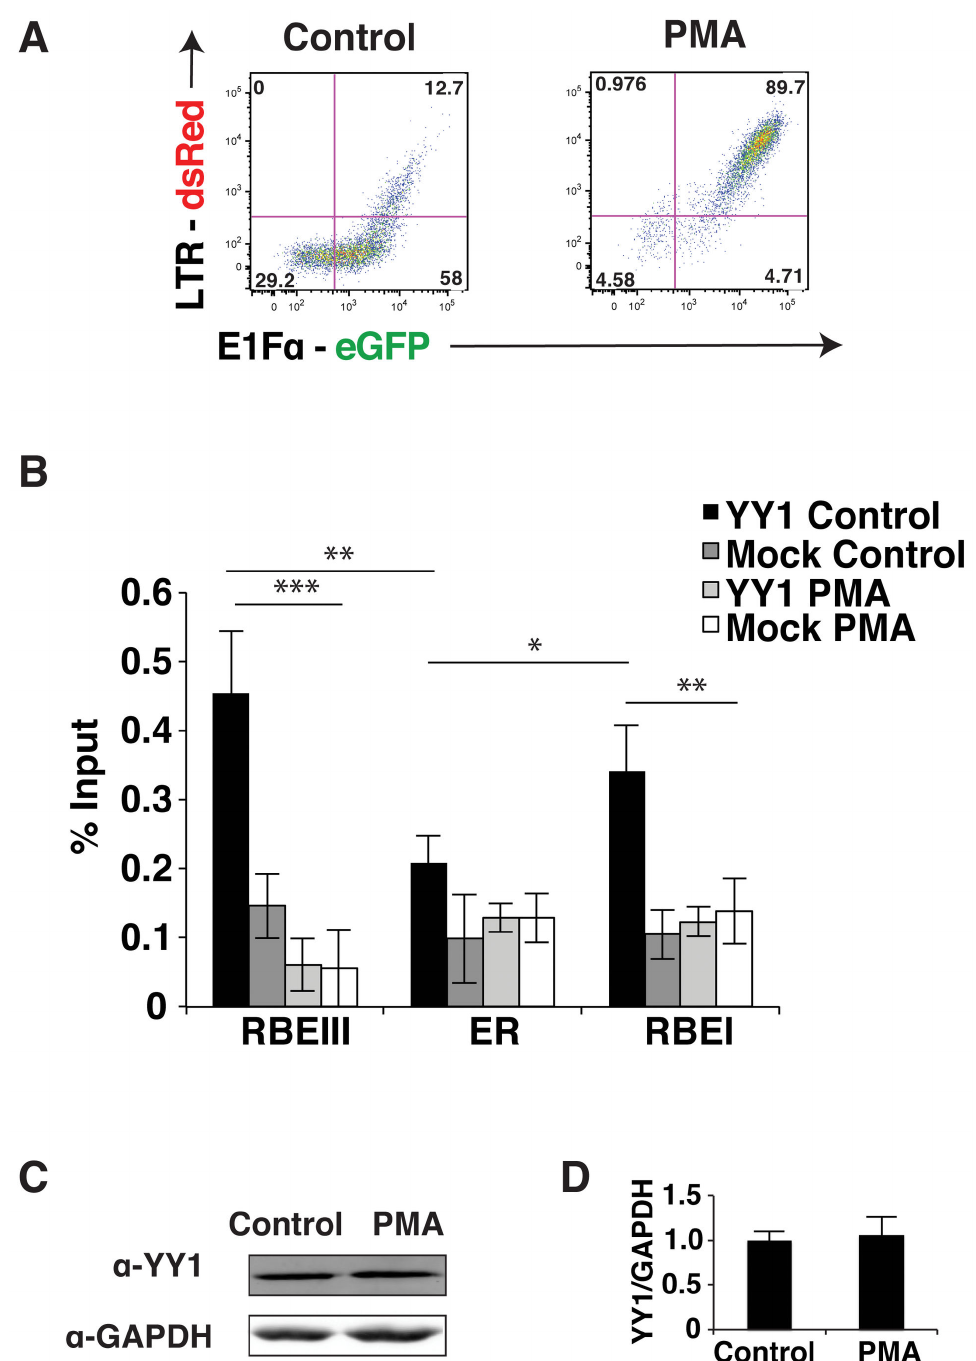
Figure 3. YY1 dissociates from the HIV-1 LTR in stimulated Jurkat-tat cells. Panel A : Flow analysis of the untreated control (left) and PMA (right) induced Jurkat-tat cells bearing integrated pTY-LAI-dsRed reporter mini-virus. Expression of eGFP is indicated on the x-axis and dsRed expression on the y-axis. Panel B : Representative clones of Jurkat-tat cells infected with the wild type reporter virus induced with PMA or untreated (control) were used for ChIP analysis with YY1 antibody, using the primers indicated in Figure 2B. Panel C : Immunoblots of control and PMA induced Jurkat-tat cell lysates with YY1 antibody. Panel D : Immunoblot quantification of control and PMA induced cells using the Odyssey Infrared Imaging System. The y-axis represents the amount of YY1 divided by the amount of GAPDH normalized to one. The error bars show the standard deviation. * Represents P values ≤ 0.05, ** represents P values ≤ 0.01, *** represents P values ≤ 0.001. doi: 10.1371/journal.pone.0077052.g003 PLOS ONE |